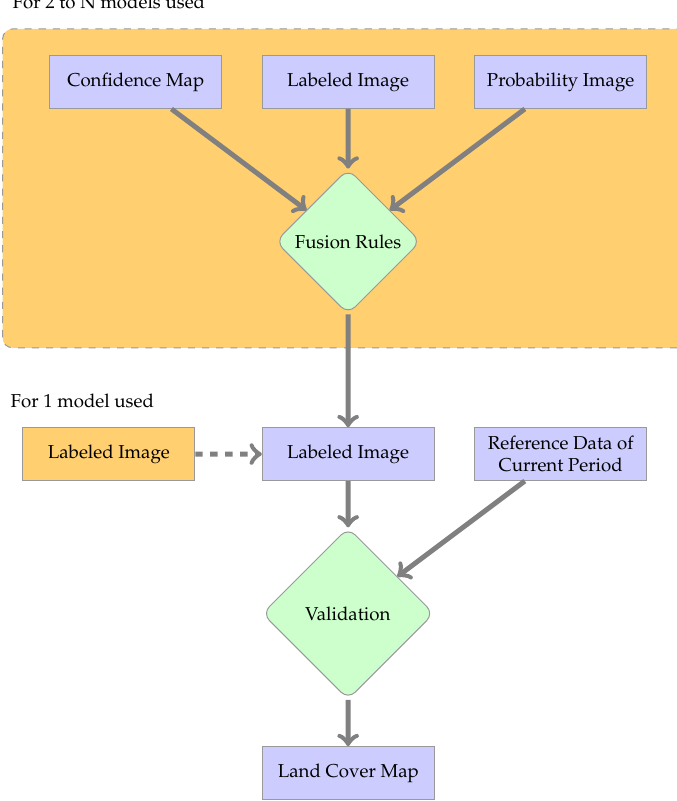
Figure 4. Workflow of the post-processing chain. When only one classifier is used in Step 2 (standard supervised, naive or single classifier case), the labeled image is directly validated. For voting methods, each product of Step 2 is used according to the fusion